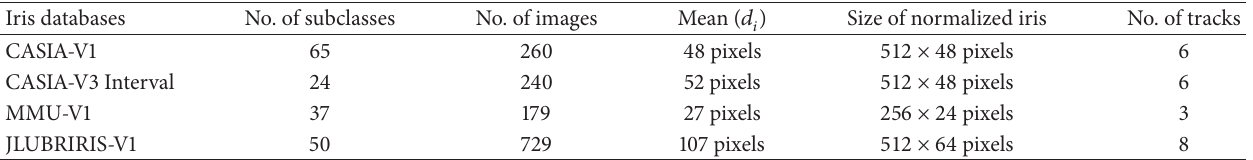
Table 3: Properties of different iris